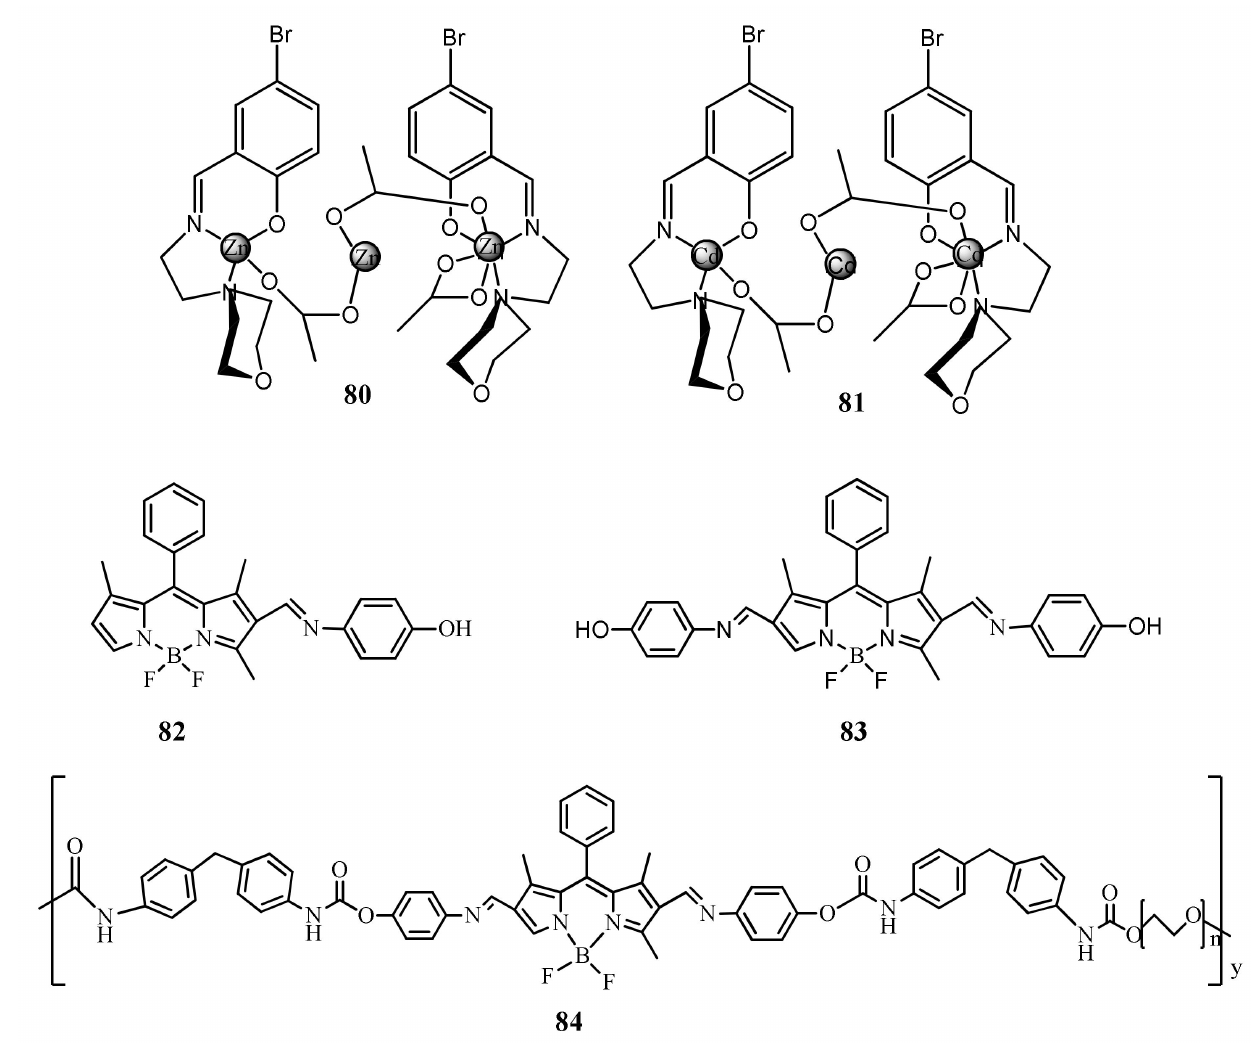
Figure 27. Molecular structures of the sensors 80 to 84